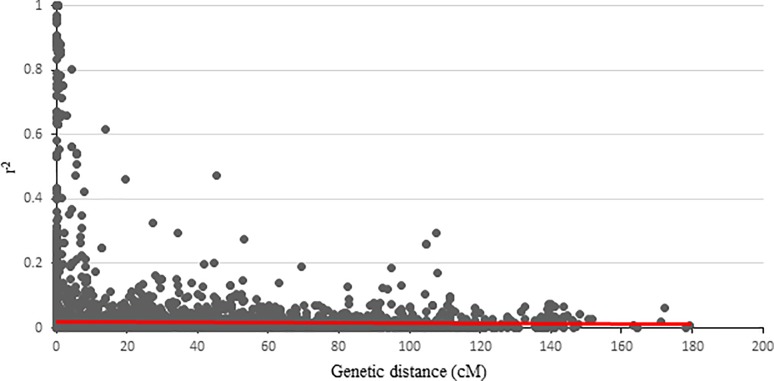
LD decay of marker pairs by increasing genetic distance (cM).The horizontal line indicates the 90th percentile distribution of unlinked r2.